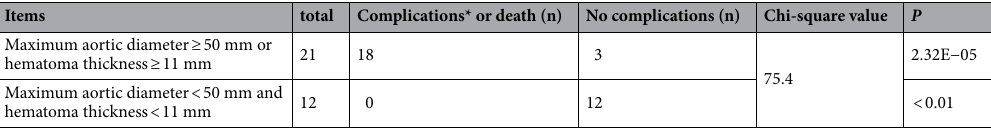
Table 4. Comparison of initial aortic diameter and hematoma thickness for conservative treatment of Stanford type A IMH. *Progression of aortic dissection, pseudoaneurysm, rupture, visceral arterial perfusion, lower limb